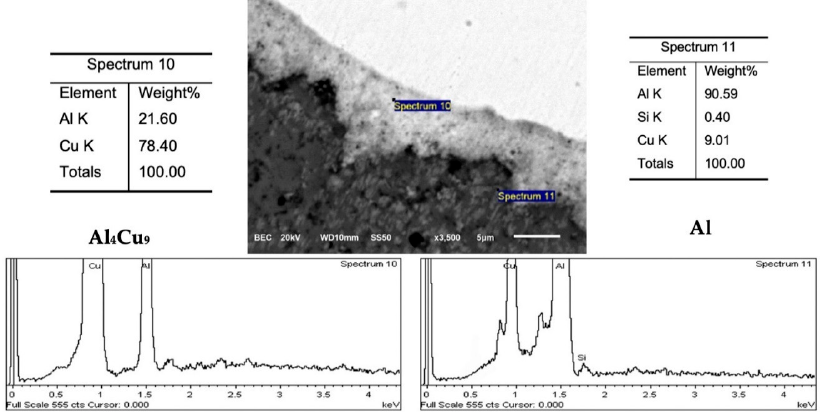
found in weld zone of FSW Al6061-Cu, performed at 1150 rpm and 20 mm/min.